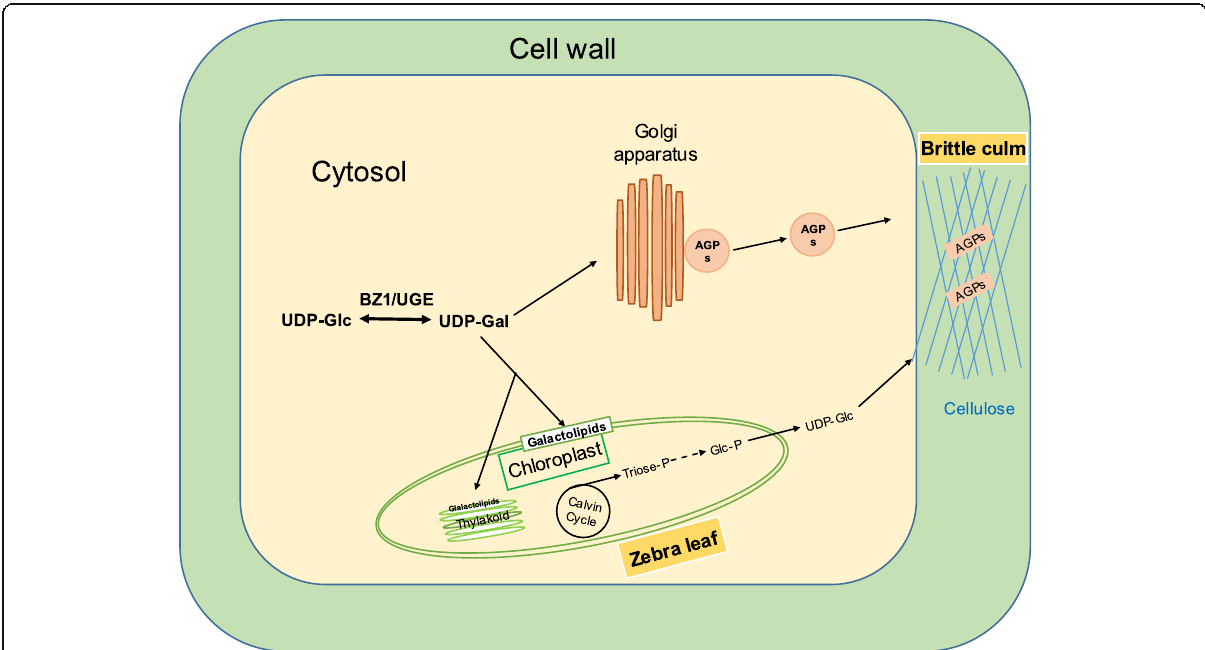
Fig. 8 A hypothetical model for the role of BZ1 in the AGPs and galactolipid biosynthetic pathway for cell wall biosynthesis and chloroplast membranes formation,